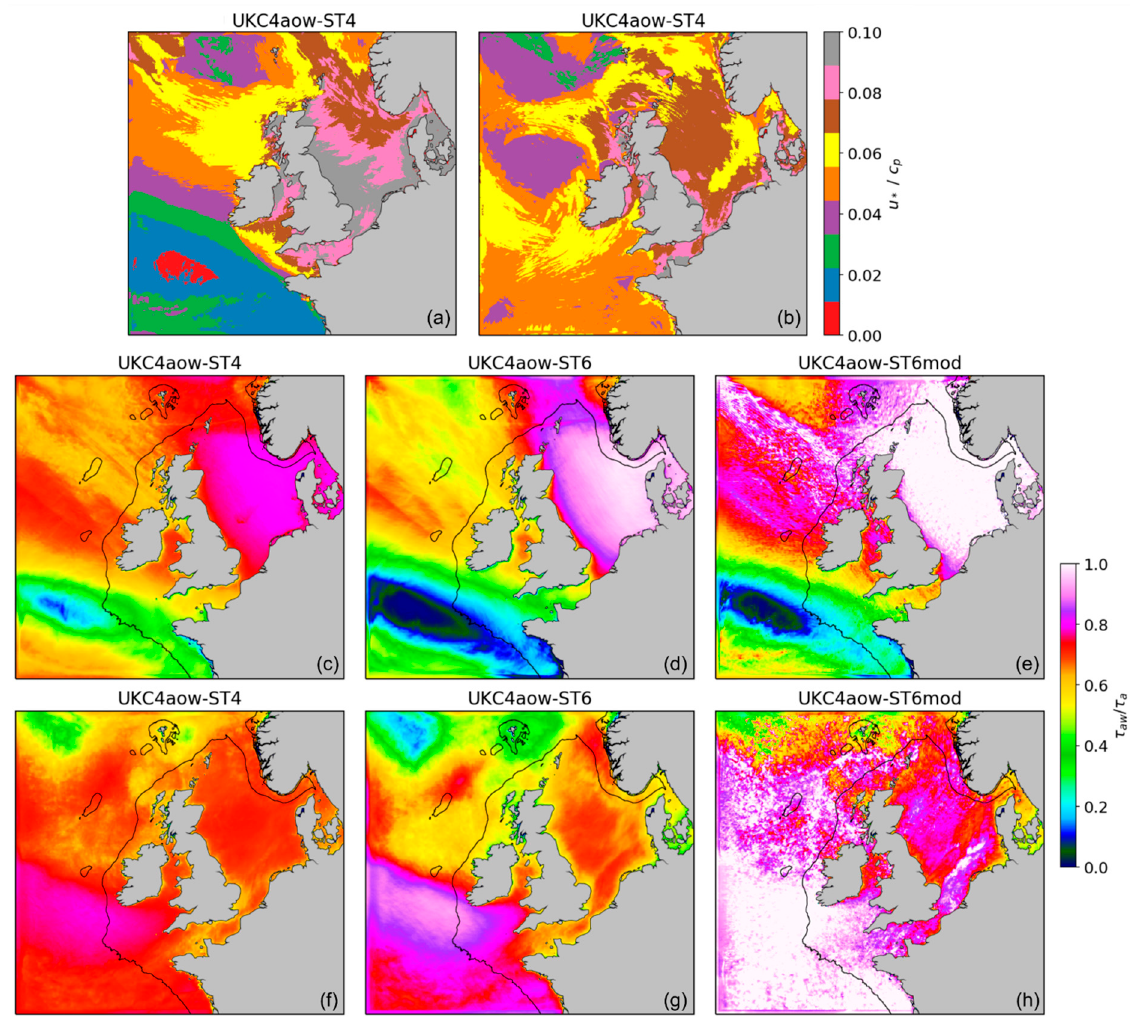
Figure 11. ( a , b ) Maximum inverse wave age u ∗ / c p and ( c – h ) average ratio τ aw / τ a distribution during storm Xaver ( c – e ) and storm Ruth ( f – h ) for the different UKC4aow configurations. UKC4aow configurations are ( c , f ) #ST4, ( d , g ) #ST6 and ( e , h ) #ST6mod physics. Wave age is defined as the ratio of a characteristic wind friction velocity to the surface wave phase speed at the peak of the wave spectrum ( u ∗ / c p ) as per Sullivan et al. [89].